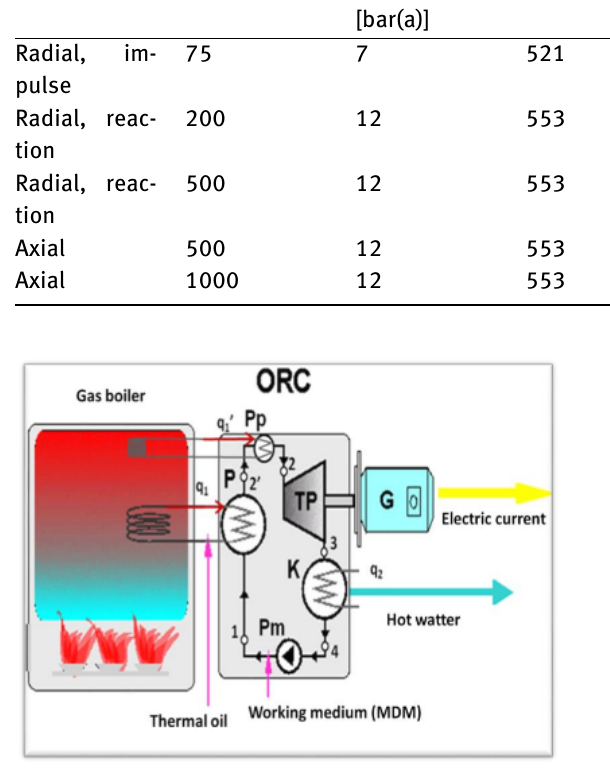
Figure 1: The schematic of the IMP PAN multitask ORC test